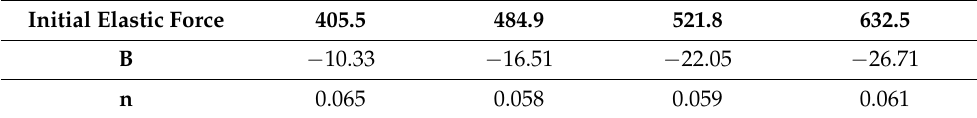
Table 1. Values of B and N corresponding to different elastic forces.